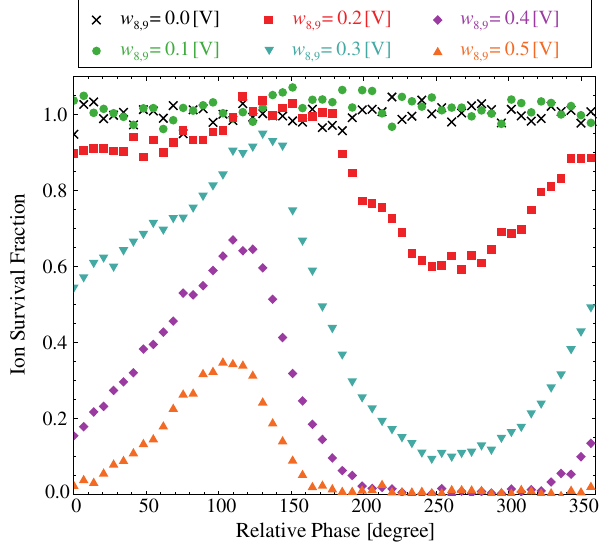
FIG. 13. Dependence of ion losses on the relative initial phase of the two sinusoidal dipole perturbations of various strengths (S-POD data). The crossing speed has been fixed at u ¼ 1 . 6 × 10 − 4 . The range of tune sweeping is the same as assumed in Fig.